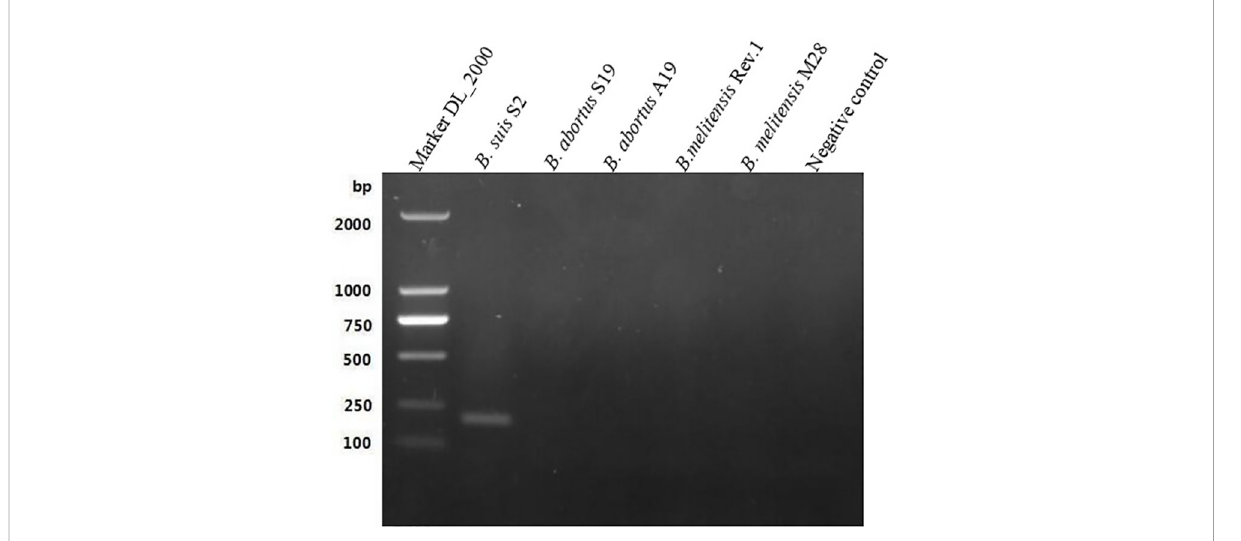
FIGURE 1 Polymerase chain reaction results of the GL_0002/89 gene. It was fotmd that the expected sizes (201 bp) were ampli fi ed only in the S2 vaccine strain, but not ampli fi ed in the B. abortus and B.melitensis strains tested in this study.